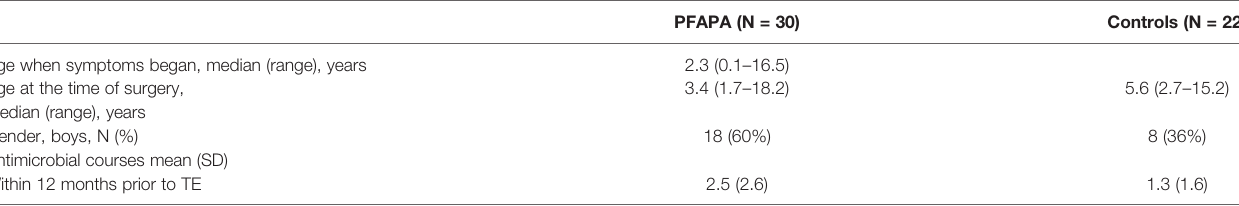
Data on age at onset of symptoms, time of surgery, and antimicrobial course are